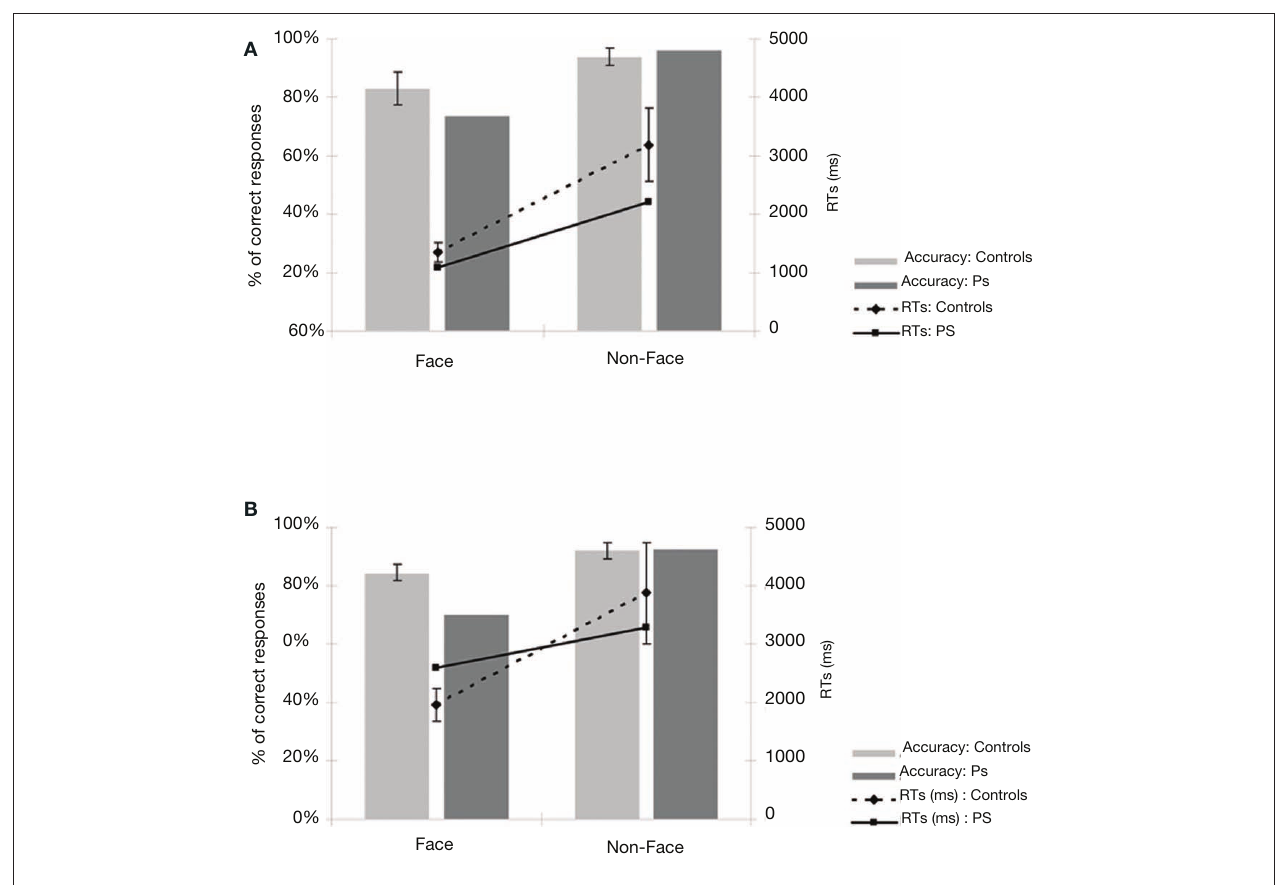
“Non-face” stimuli. PS’ accuracy rates are in the normal range, both for the “Face” as for the “Non-face” items. If anything, PS is even faster than control participants. Bars in the graph represent the standard errors of the